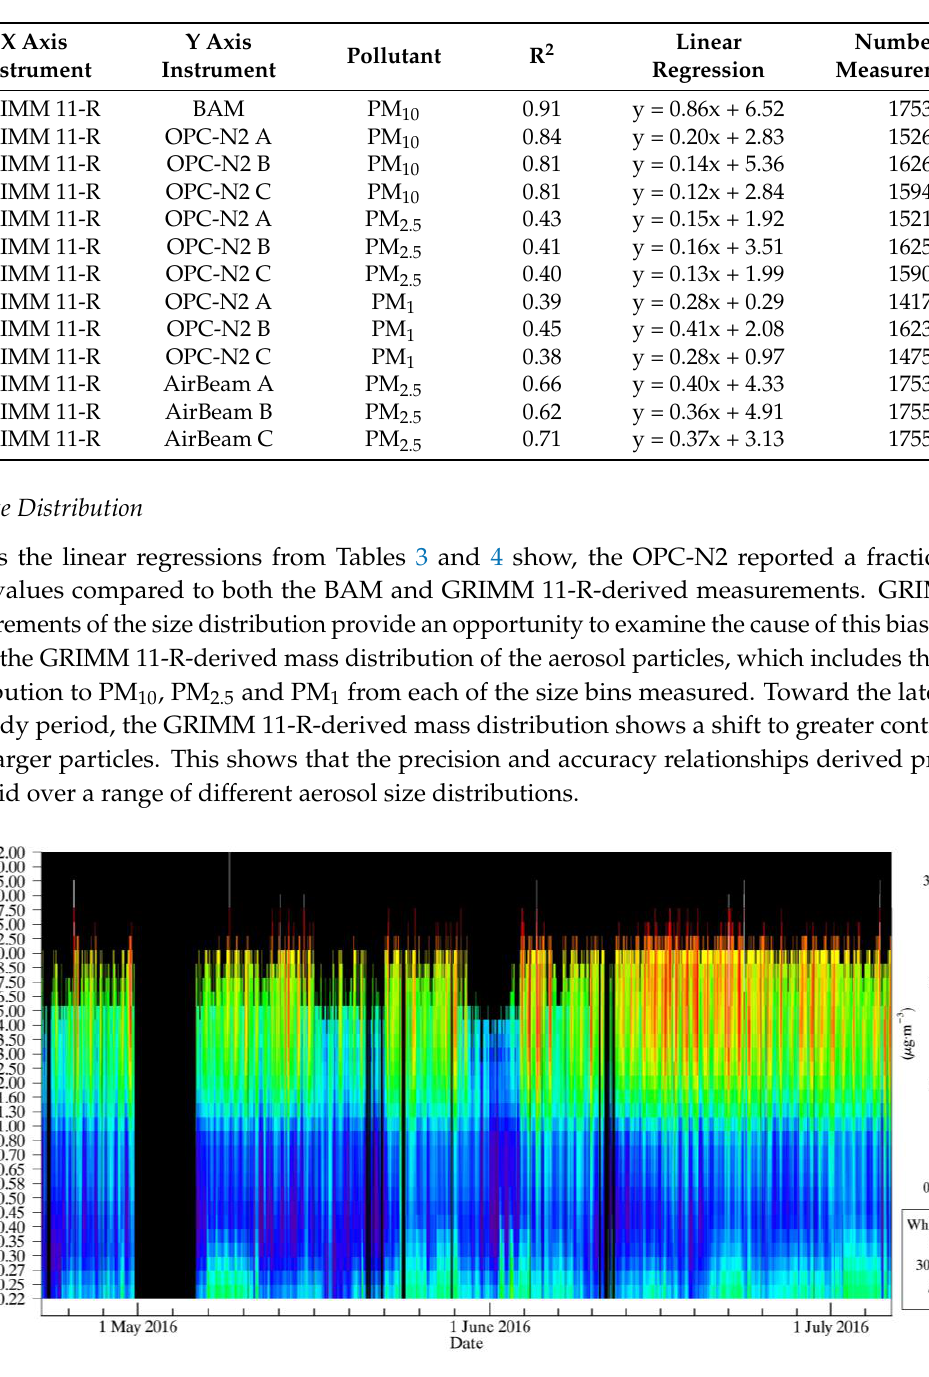
Figure 6. GRIMM 11-R-derived mass distribution over the course of the study.